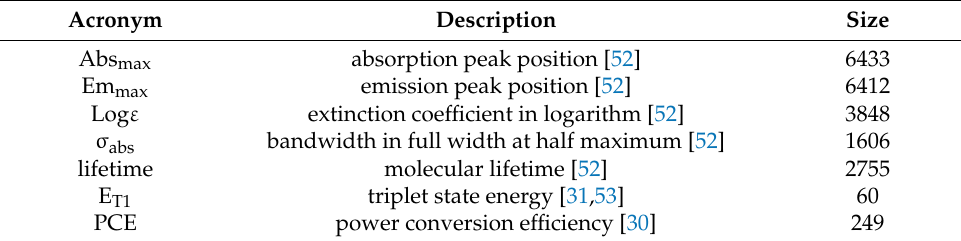
Table 8. Overview of the datasets of material